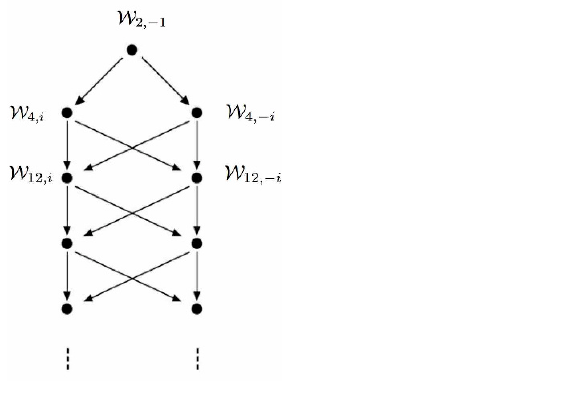
Figure 4 . Sub-module structure of W 2 ; (cid:0) 1 for q = e 3 i(cid:25)= 8 . Note the appearance of sub-modules iso- morphic to W 4 ; (cid:6) i , which lead to glueing of standard modules into bigger, indecomposable modules, and Jordan cells for the transfer